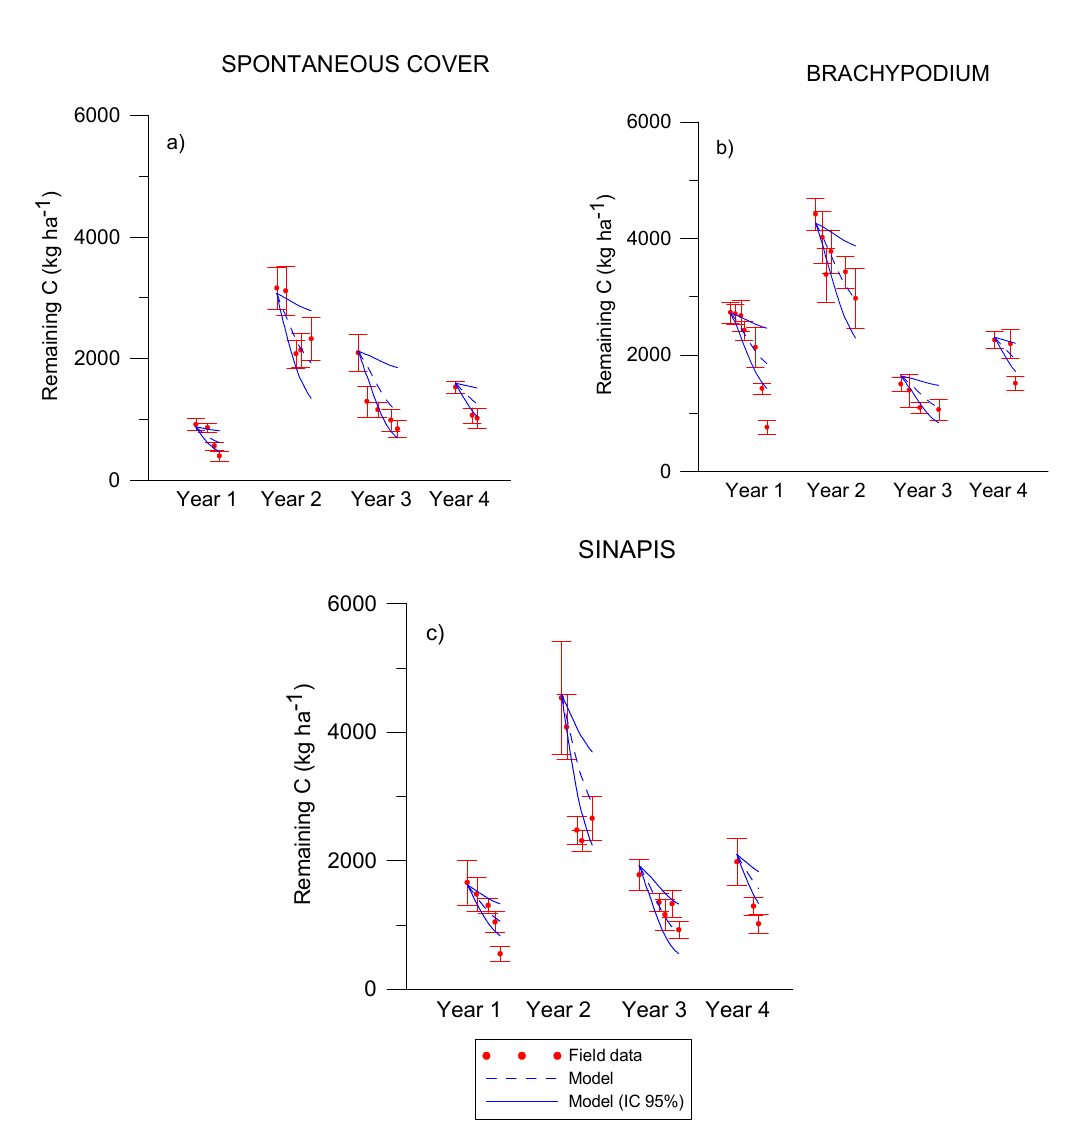
Figure 2. Measured and modelled C amounts in aboveground residues during the four decomposition cycles for spontaneous cover ( a ), Brachypodium ( b ) and Sinapis ( c ). The dashed lines represent estimations from the Rickman model [40].